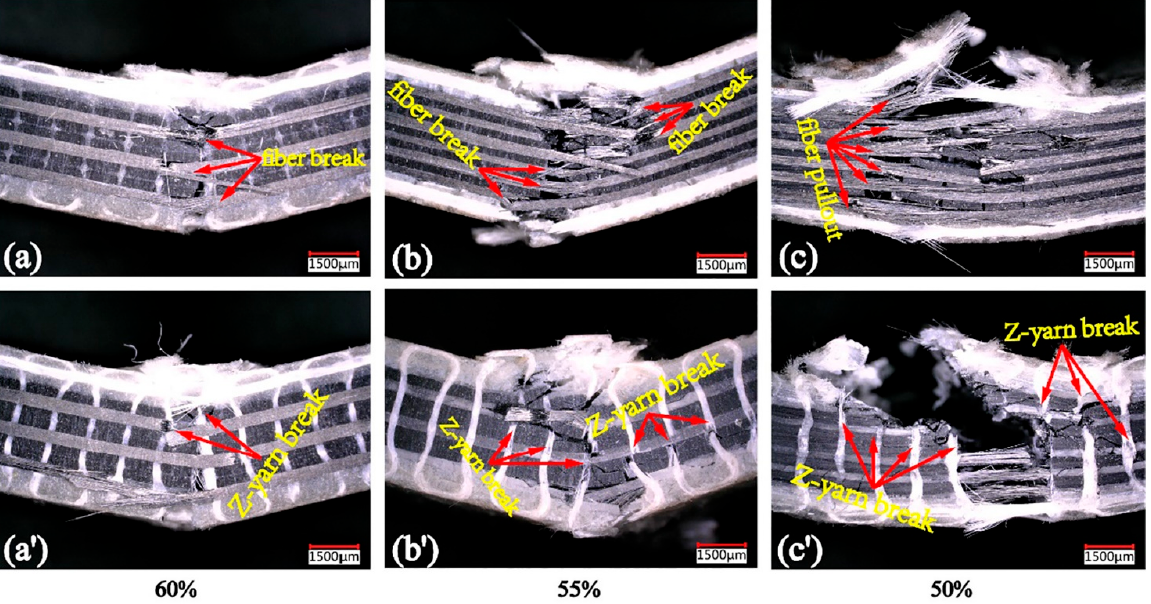
Figure 42. Exemplary fatigue failure process of a 3D hybrid PMC structure under different stress levels: ( a , a’ ) 60%; ( b , b’ ) 55%; ( c , c’ ) 50%, adapted with permission from Ref. [127]. Copyright © 2019 Elsevier